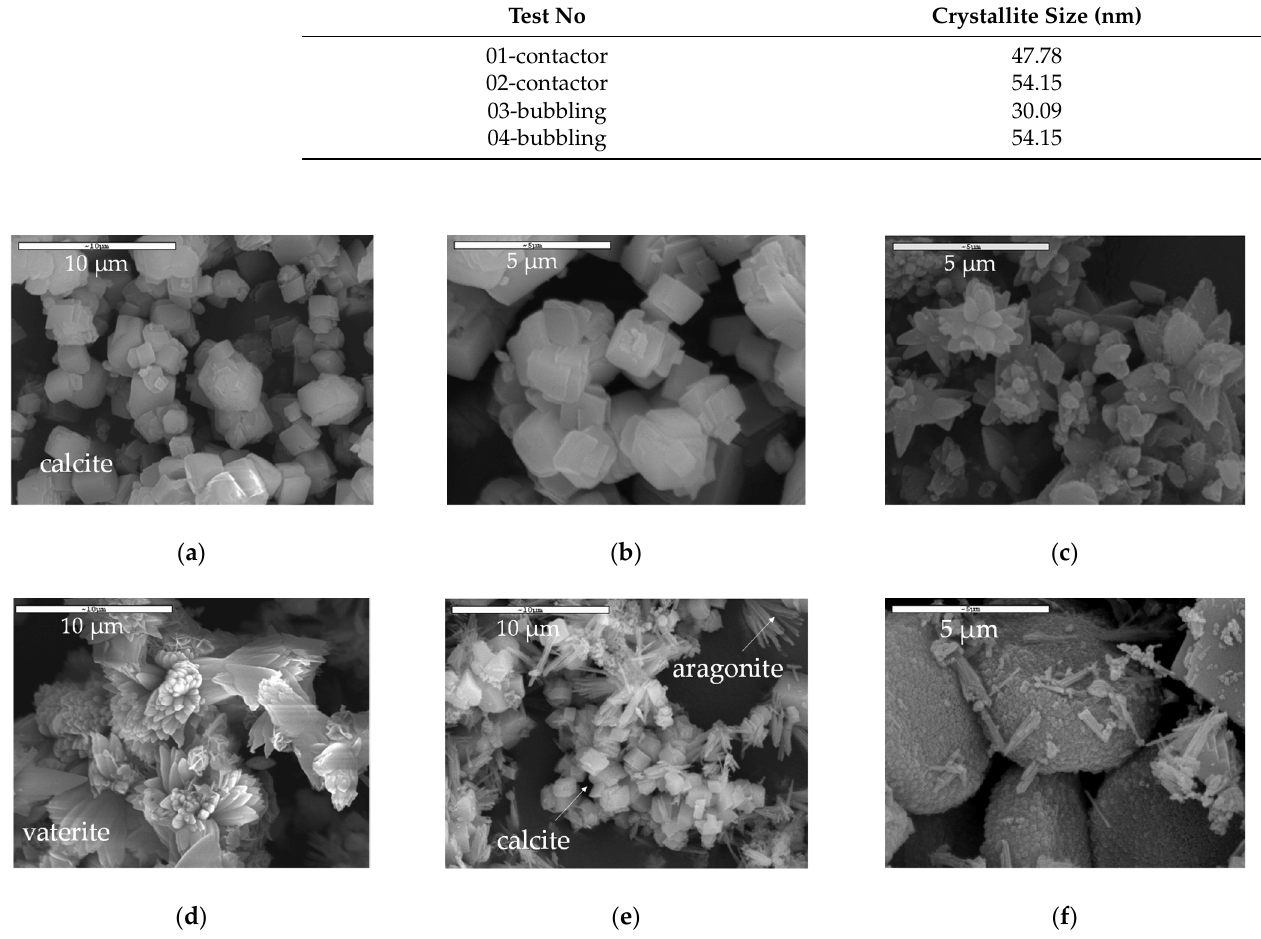
Figure 3. SEM analysis results of CaCO 3 samples generated in ( a ) the contactor mode (code: 01-contactor) at lower magnification; ( b ) the contactor mode (code: 01-contactor) at higher magnification; ( c ) in the contactor mode (code: 02-contactor) at higher magnification, ( d ) the bubbling mode (code 03-bubbling) at lower magnification, ( e ) in the bubbling mode (code 04-bubbling) at lower magnification, ( f ) in the bubbling mode (code 04-bubbling) at higher magnification.